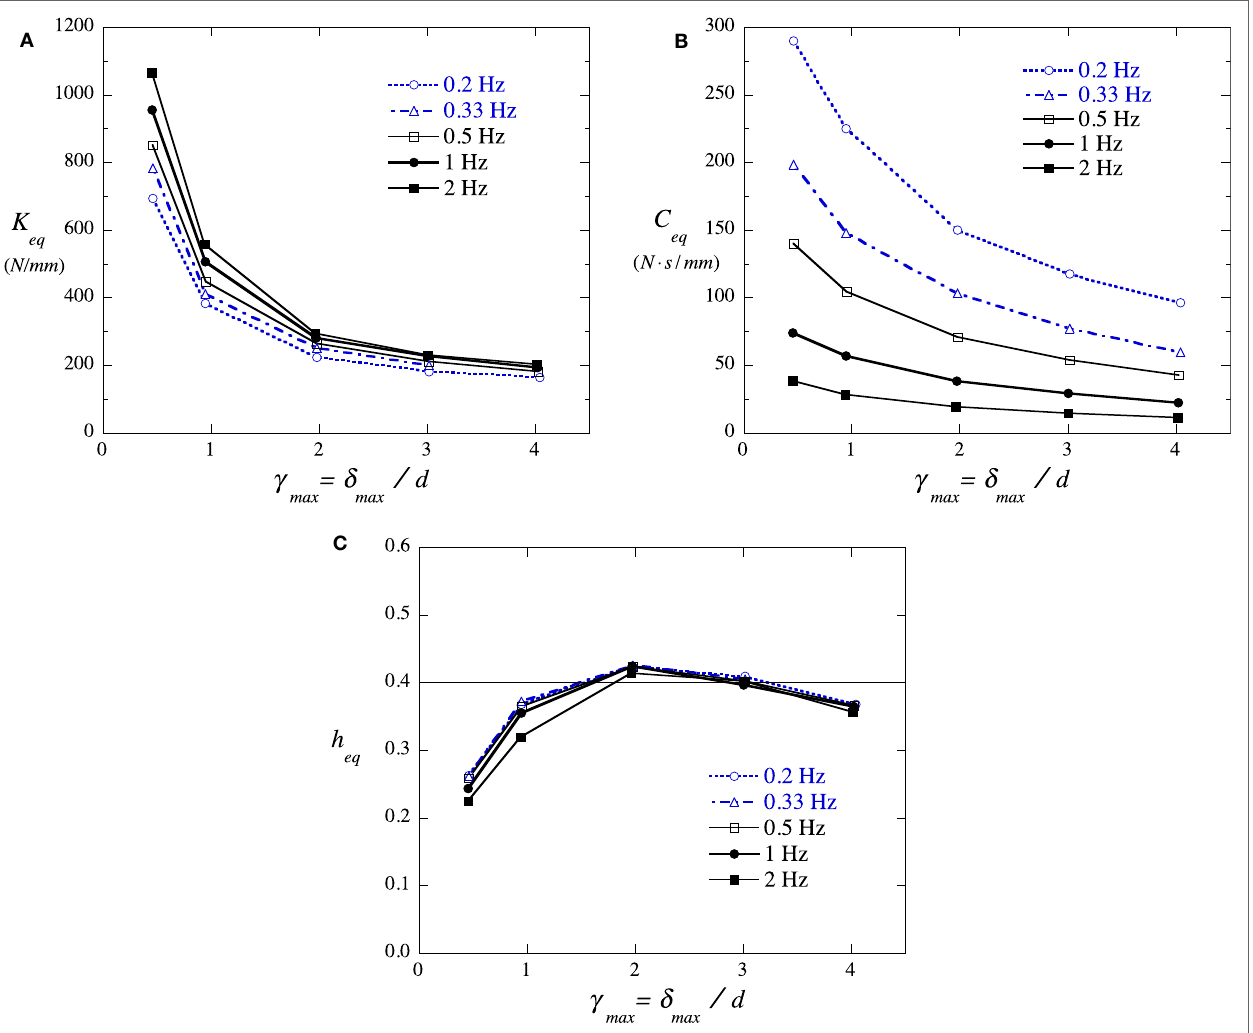
FIGURE 6 | Amplitude and frequency dependency of mechanical characteristics of VE material . (A) equivalent shear stiffness, (B) equivalent damping coefficient, and (C) equivalent damping